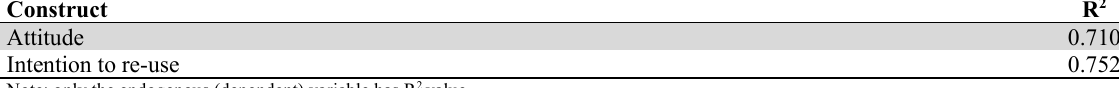
Coefficient of Determination